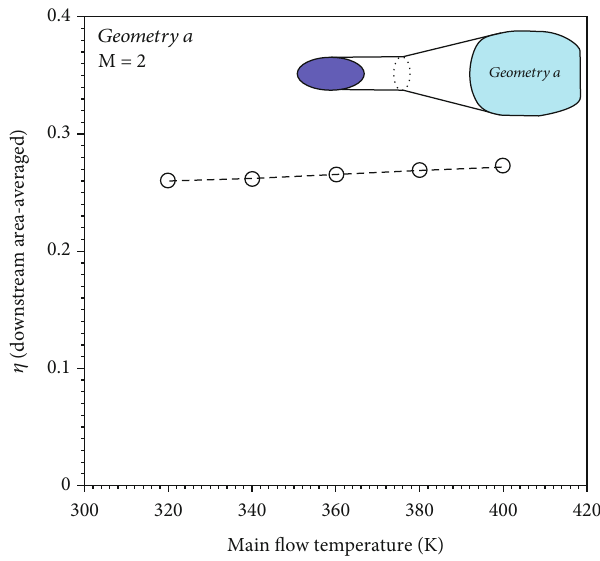
Figure 9: Temperature independence test for Geometry a at M = 2 : 0